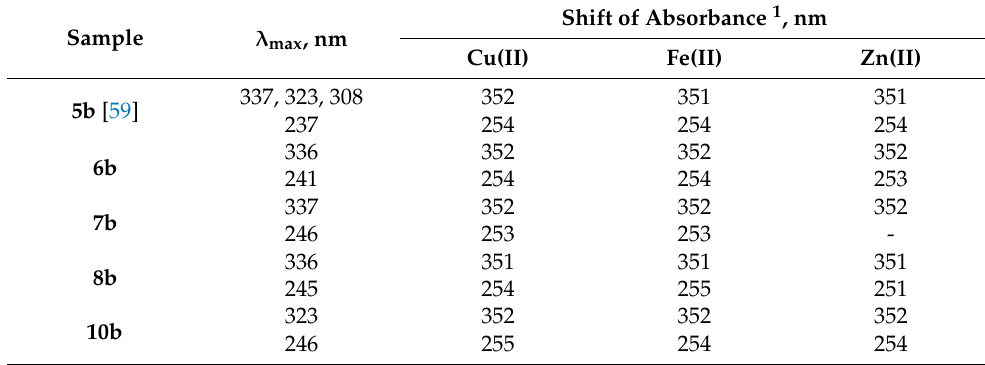
Table 5. Data on UV spectra of 5b , 6b , 7b , 8b , and 10b and their metal